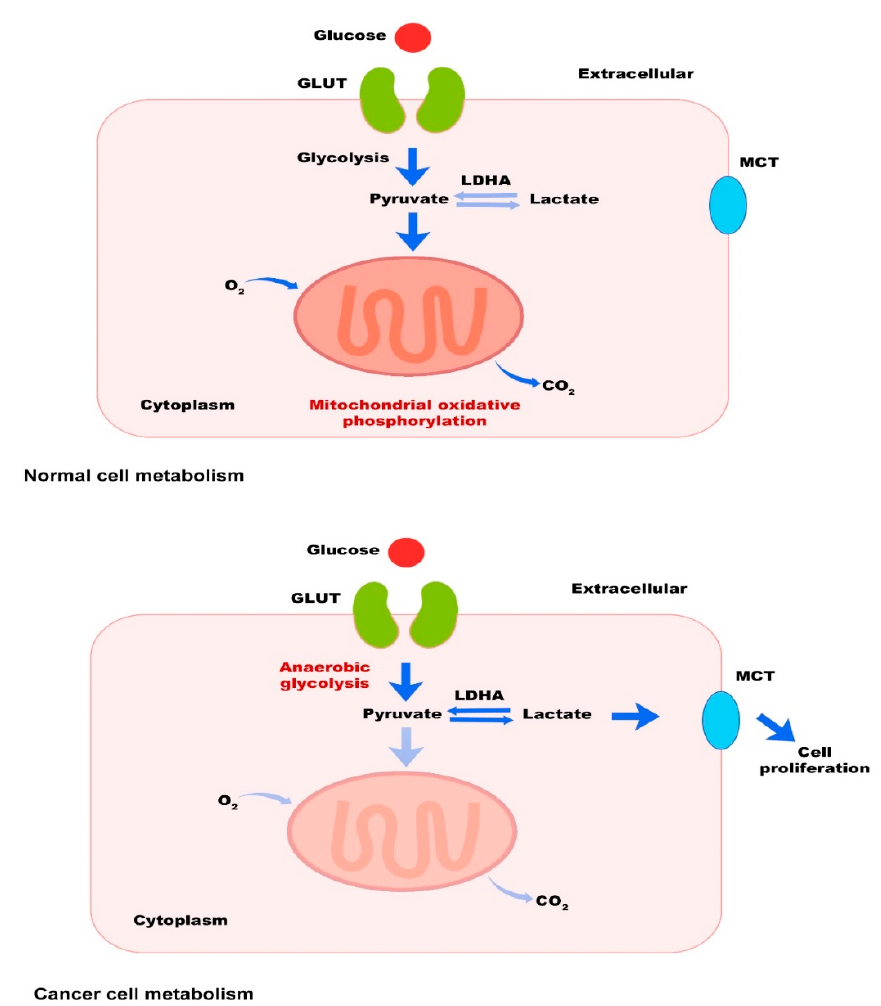
Figure 1. The Warburg effect. Most tumor cells produce energy, principally through glycolysis in the cytosol, producing lactic acid even in the presence of oxygen. MCTs catalyze the proton-linked transport of produced lactate across cell membranes. On the other hand, normal cells use oxidative phosphorylation in the mitochondria to produce energy under aerobic conditions.